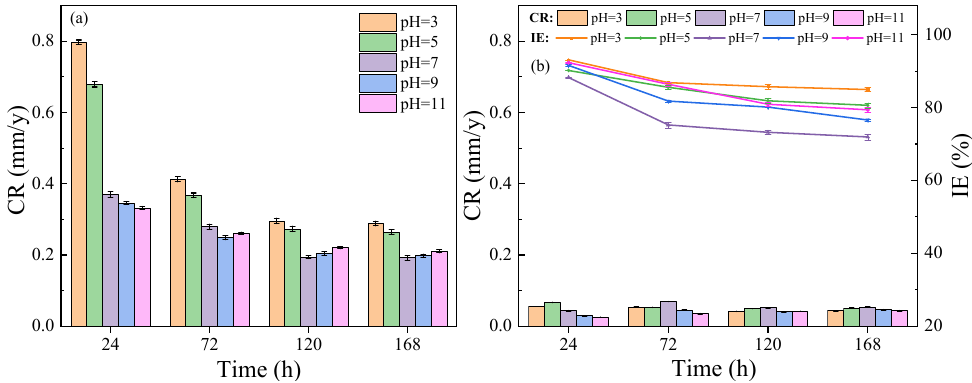
Figure 10. corrosion rate and inhibition efficiency of L80 in different pH solution of 3.5 wt.% NaCl at 25 °C with and without OIM@PAM , ( a ) without OIM@PAM and ( b ) with OIM@PAM . 25 ◦ C with and without OIM@PAM , ( a ) without OIM@PAM and ( b ) with OIM@PAM